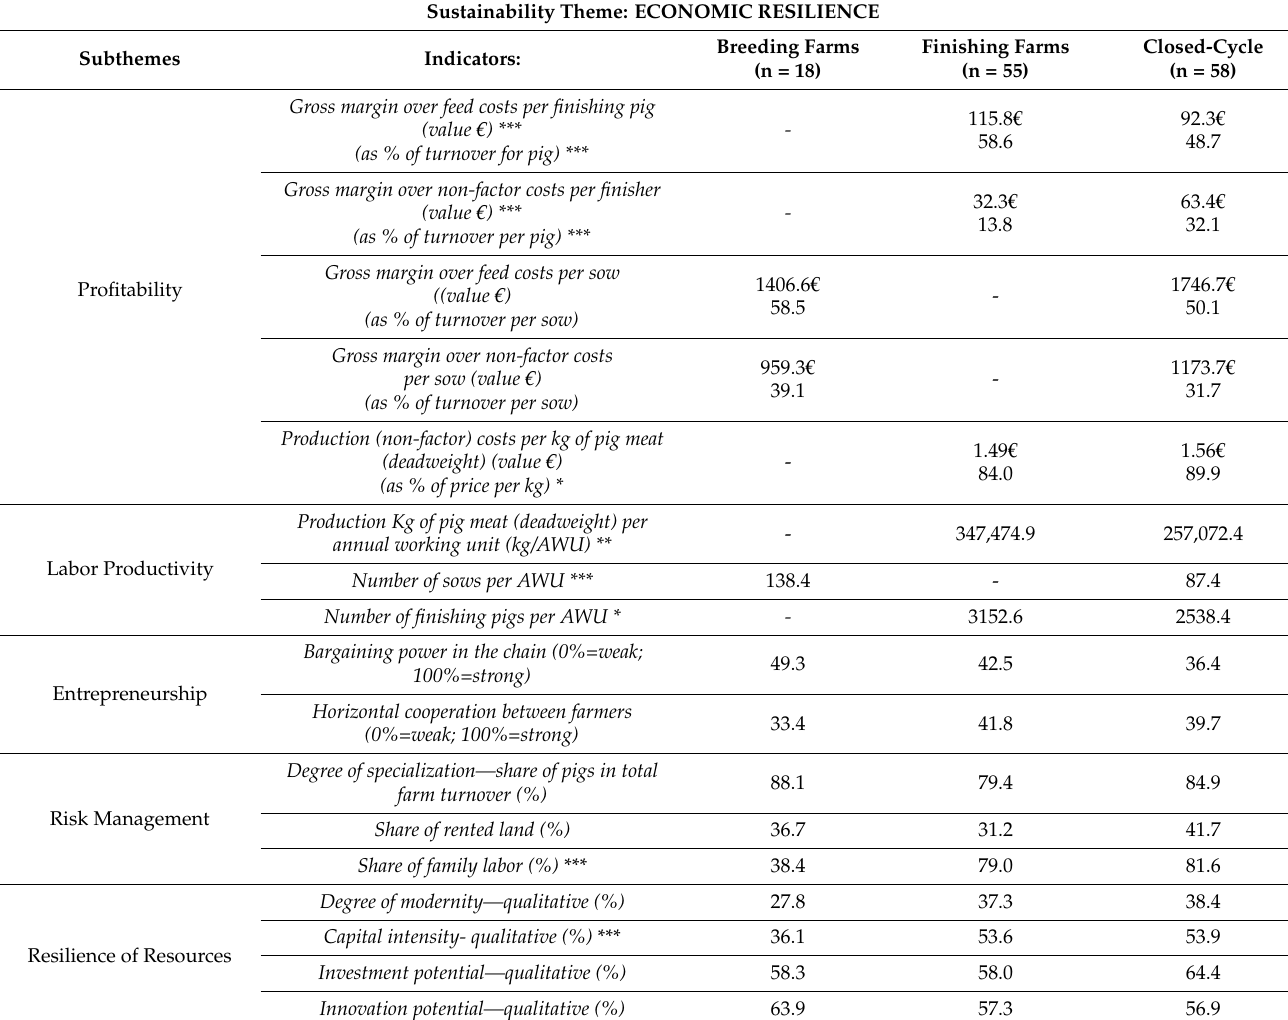
Table 5. Economic resilience indicators across farm